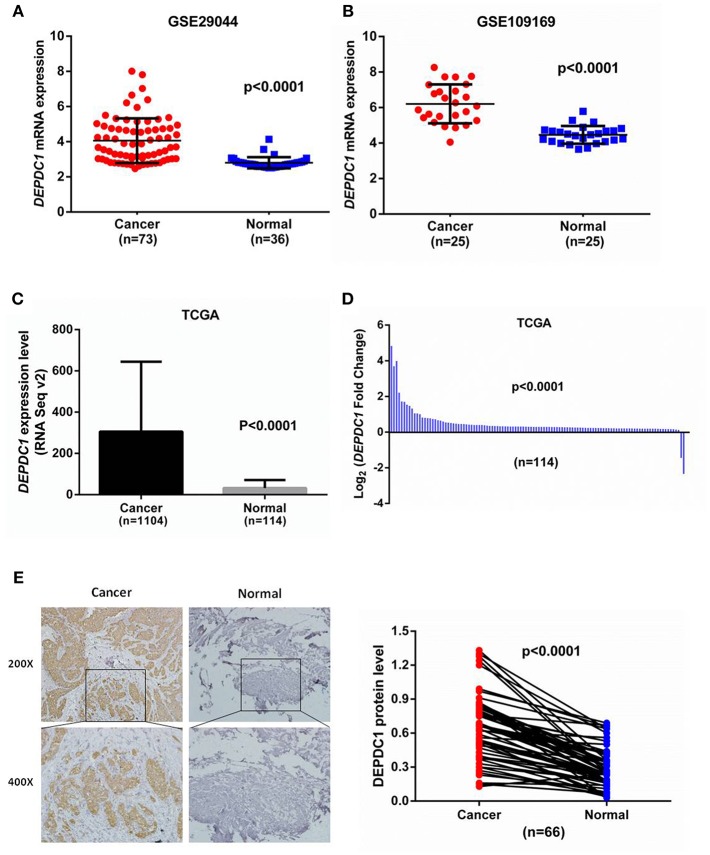
DEPDC1 was significantly upregulated in breast cancer. (A) DEPDC1 mRNA level was obviously higher in breast cancer specimens than in normal tissues by searching GEO dataset (GSE29044). (B) DEPDC1 expression was upregulated in human breast cancer compared to their paired normal tissues by searching GEO dataset (GSE109169). (C,D) The mRNA level of DEPDC1 was significantly increased in breast cancer tissues of the unpaired (C) and paired (D) via analyzing TCGA_BRCA database. (E) The DEPDC1 immunohistochemical staining images of 66 paired human breast cancer samples (left) and adjacent normal tissues (right).